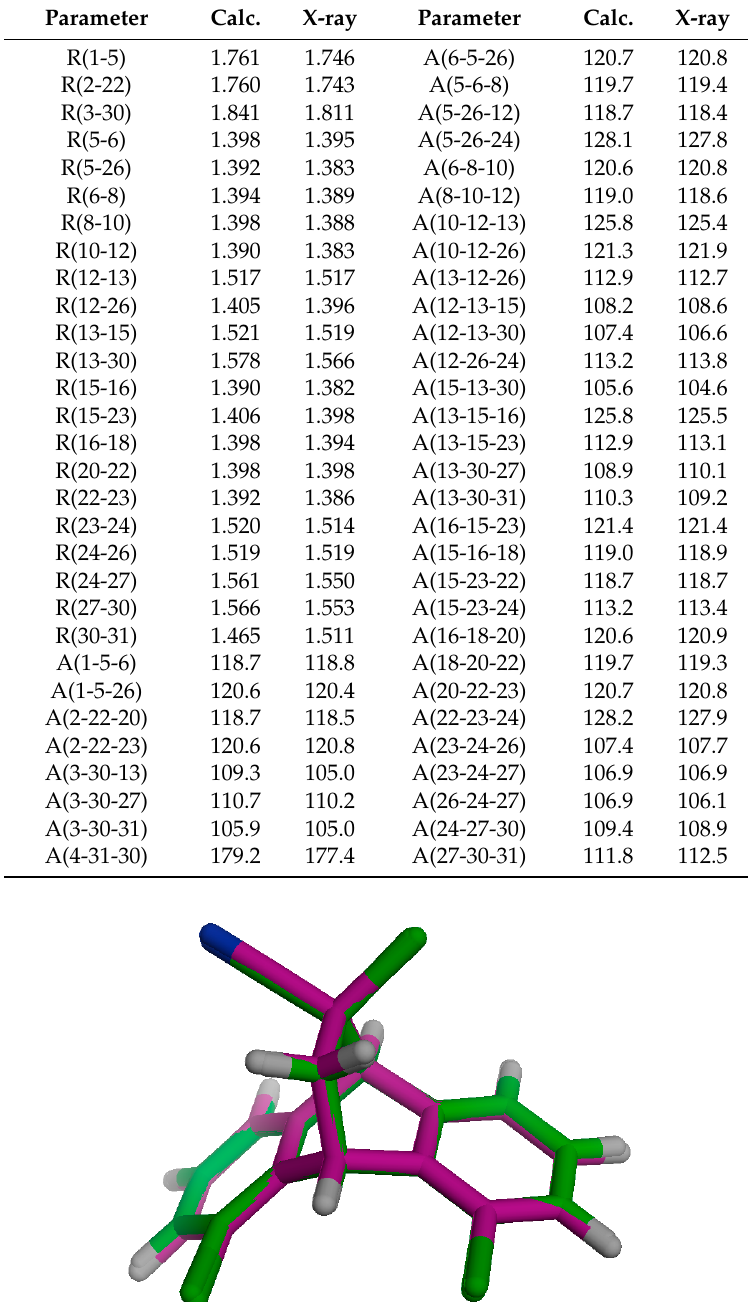
Table 3. Calculated and experimental bond distances (Å) and angles ( ◦ ) of isomer 1 . Parameter Calc. X-ray Parameter Calc.